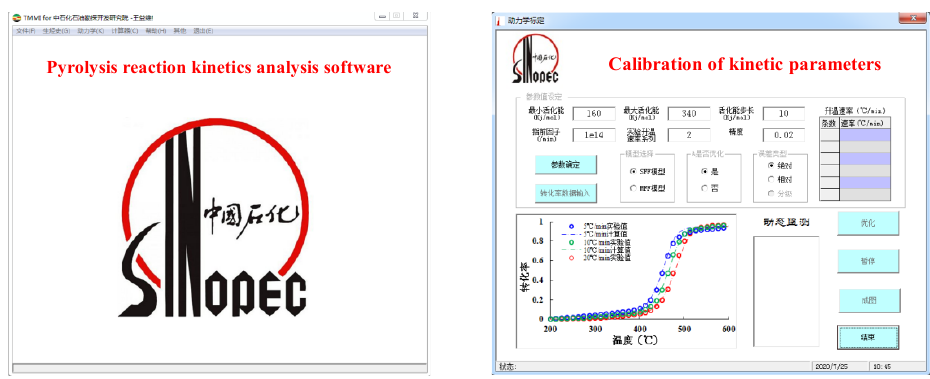
Figure 3. Kinetic software of the in situ pyrolysis of oil shale.